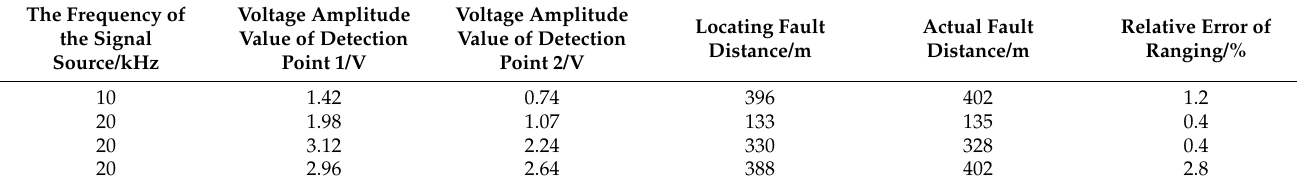
Table 5. Location results of different fault distances.